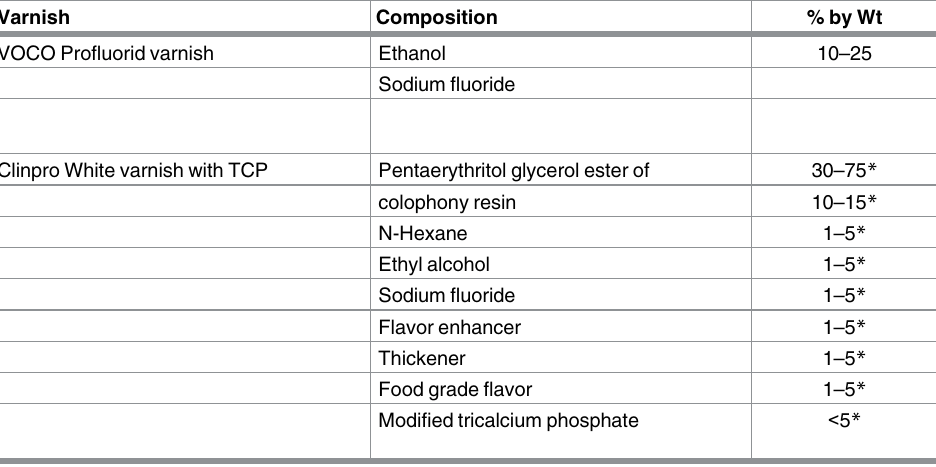
Table 1. Products composition according material safety data sheets